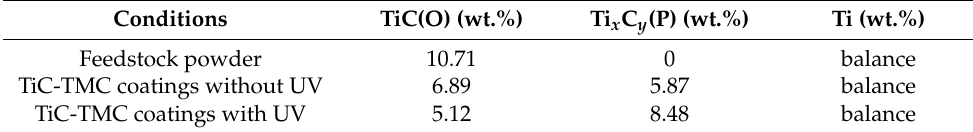
Table 3. Phase compositions of the feedstock powder and the TiC-TMC coatings with 10% TiC. Conditions TiC(O) (wt.%) Ti x C y (P) (wt.%) Ti (wt.%) Feedstock powder